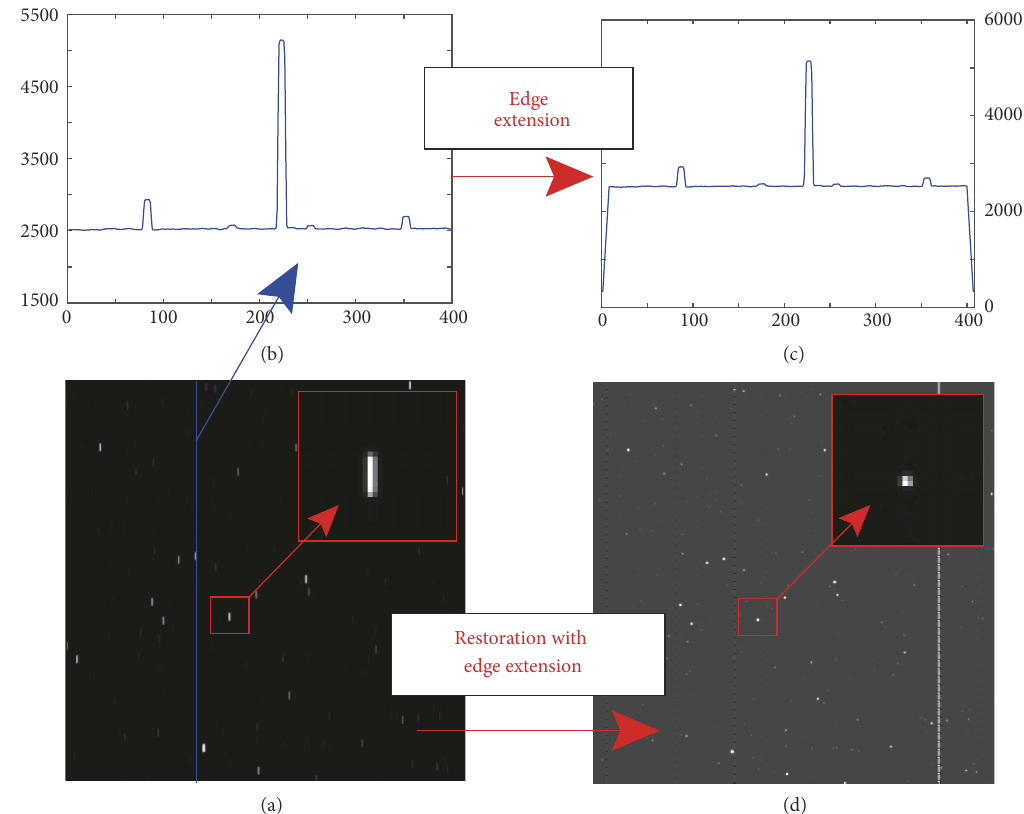
Figure 4: (a) The original image of stars. (b) The gray distribution of the 309th column in the image affected by atmospheric dispersion. (c) The gray distribution of (b) after the edge extension process. (d) The result of deconvolution of (a).